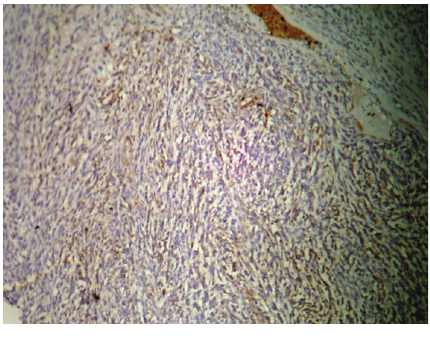
Figure 3: 10x with mitosis. Figure 4: